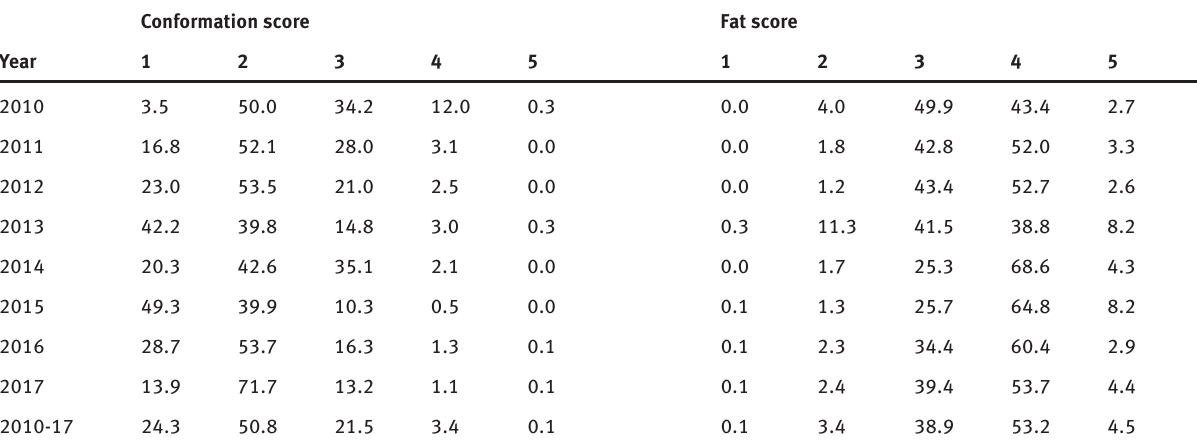
Table 3: Distribution (%) of conformation and fat scores1 for Greenlandic lambs from 2010-2017 Conformation score